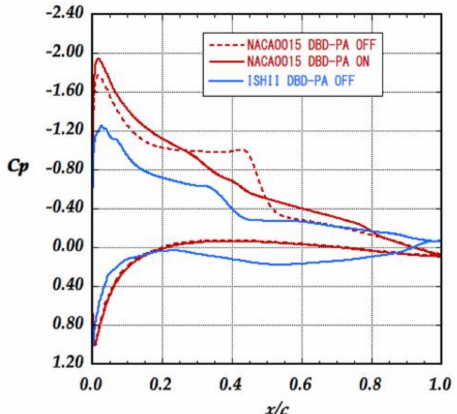
Figure 15. Chordwise pressure coefficient distributions over the airfoil surface: NACA0015 ( α = 6 ◦ ), Ishii airfoil ( α = 4 ◦ ), Re = 6.3 × 10 4 , F + = 6.0, Dc = 0.05, BR =